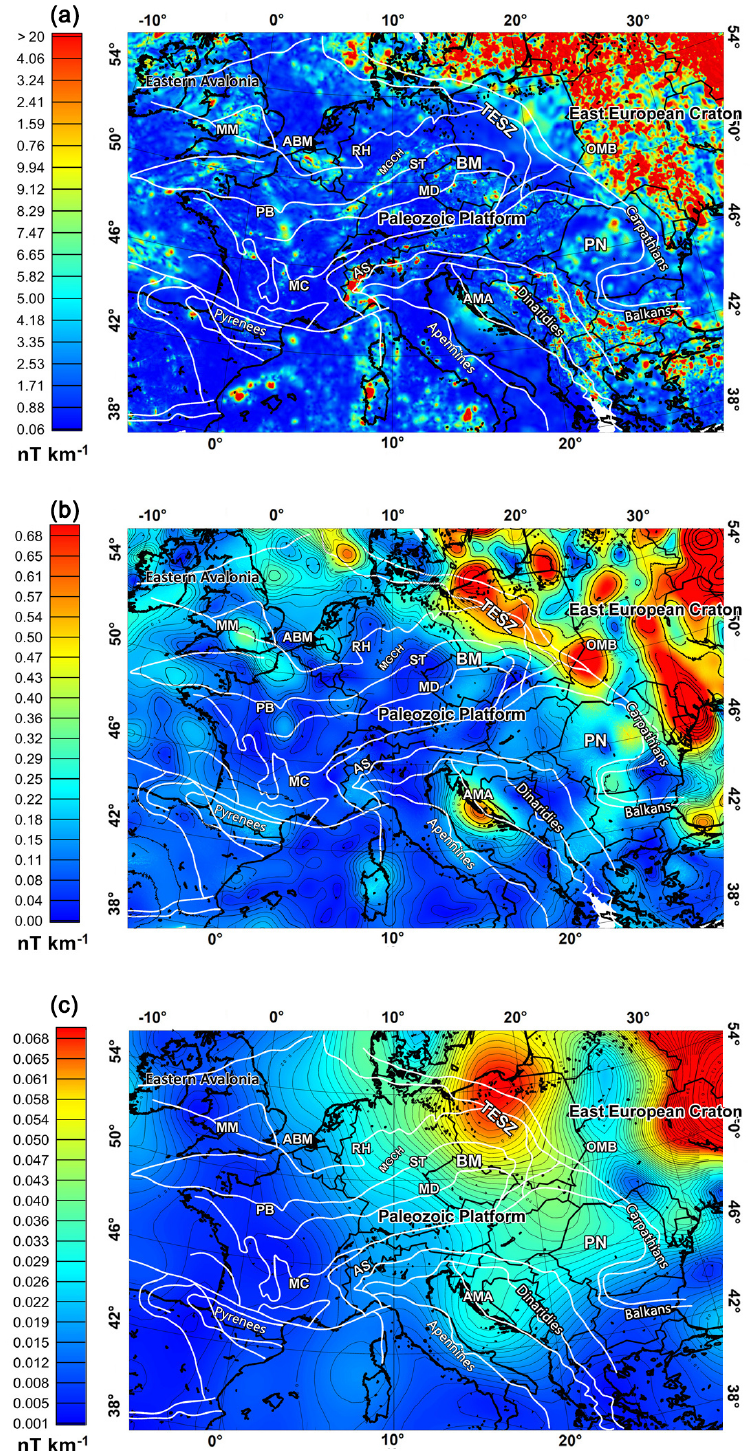
Figure 8. Total gradient intensity maps of the aeromagnetic dataset at 5km (a) and 100km of altitude (b) ; total gradient map of the MF7 magnetic field model at 350km of altitude (c) . White lines represent the main tectonic structures (from Blundell et al., 1992). ABM: Anglo- Brabant Massif; AMA: Adriatic magnetic anomaly; AS: Alpine system; BM: Bohemian Massif; MC: Massif Central; MD: Moldanubian zone; MGCH: Mid-German Crystalline High; MM: Midlands Microcraton; OMB: Osnitsk–Mikashevichi Igneous Belt; PB: Paris Basin; PN: Pannonian